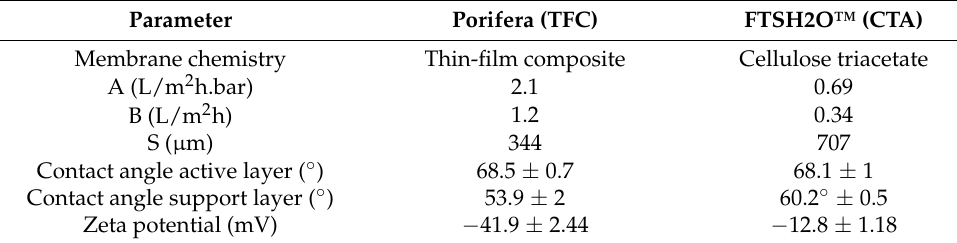
Table 1. Characteristics of Porifera and FTS H 2 O